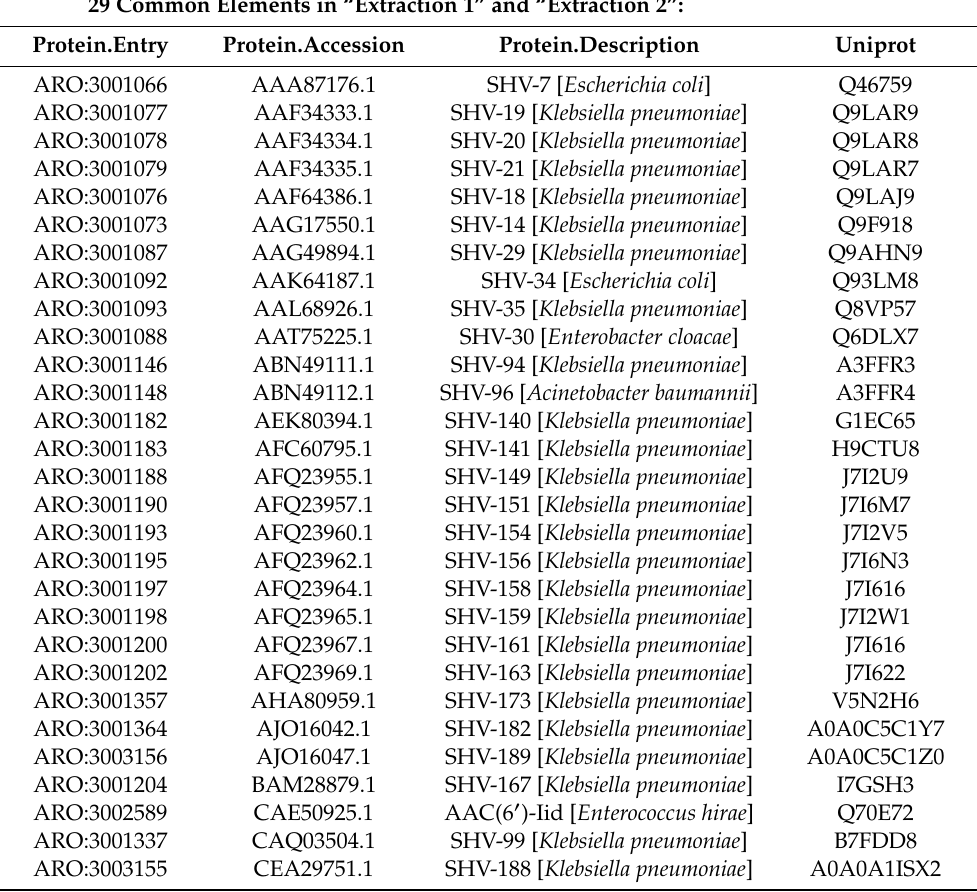
Table 2. List of the di ff erent β -lactamase isoforms detected using the CARD 15 resistome database. 29 Common Elements in “Extraction 1” and “Extraction 2”: Protein.Entry